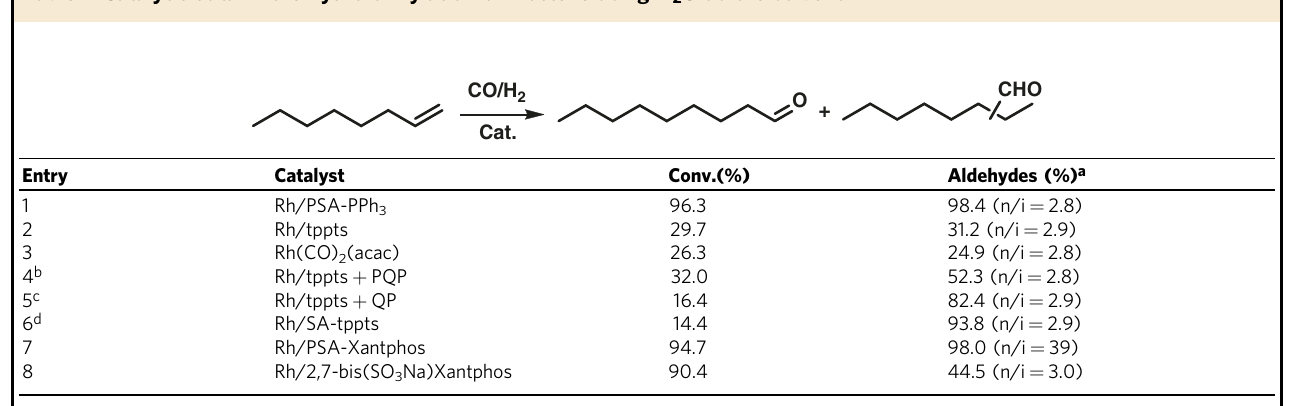
Table 2 Catalytic data in the hydroformylation of 1-octene using H 2 O as the solvent